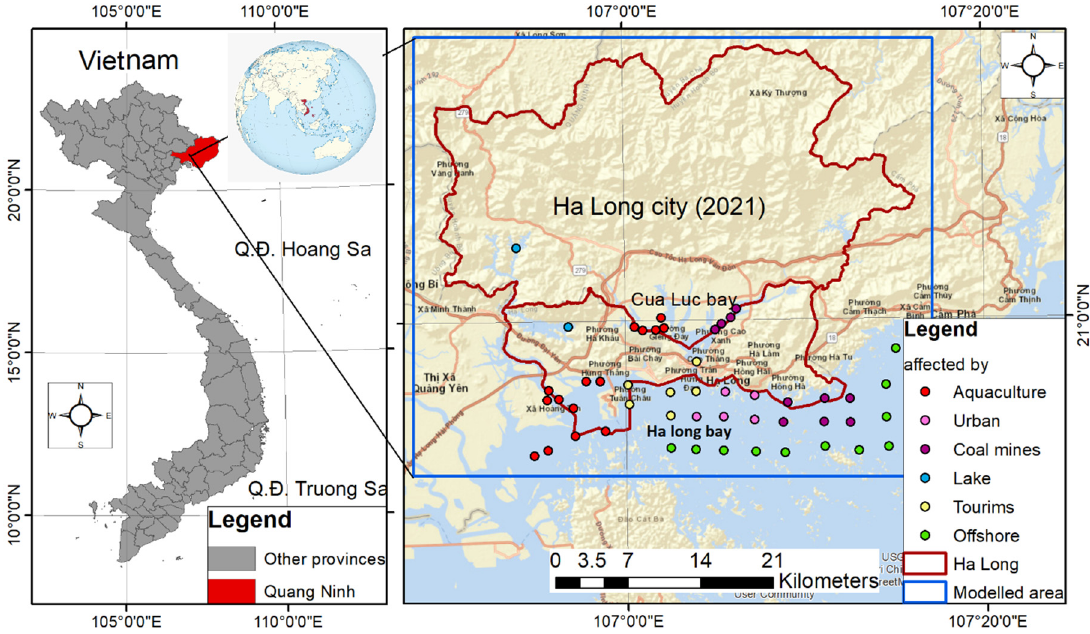
Figure 1. Location of the study area of Ha Long City in Quang Ninh Province of Vietnam with 49 points divided into six groups (distinguished using colored circles) of anthropogenic impact on chlorophyll-a concentration.